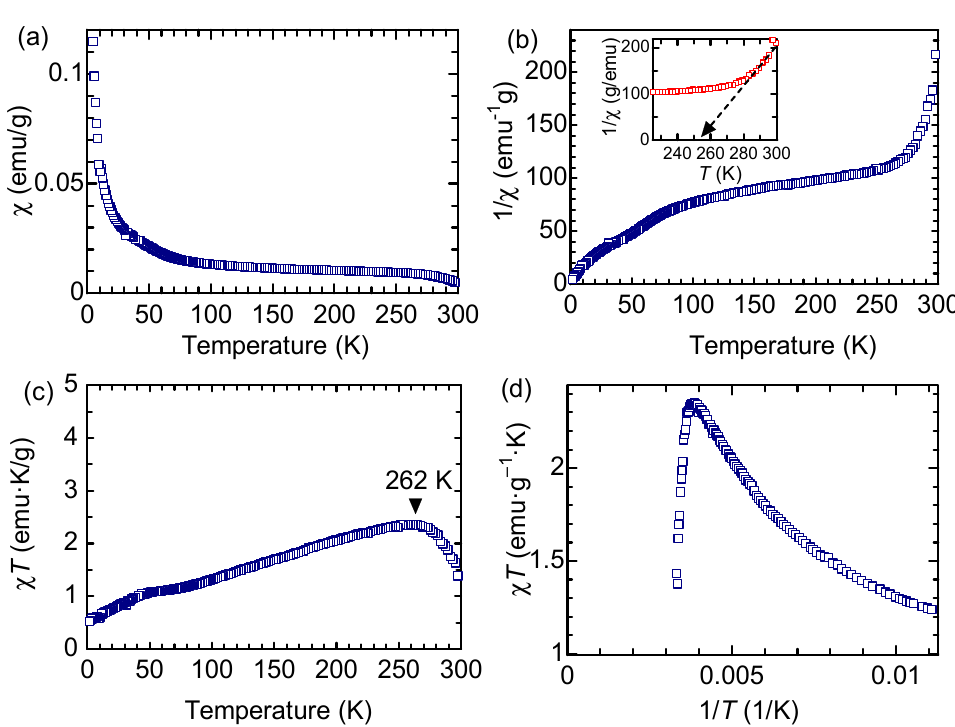
Figure 4. ( a ) χ vs. T plots. ( b ) 1/ χ vs. T plots. ( c ) χ T vs. T as Currie plots. ( d ) χ T vs. 1/ T plots as Ising plots. The inset of ( b ) shows a magnification of 1/ χ vs. T plot.